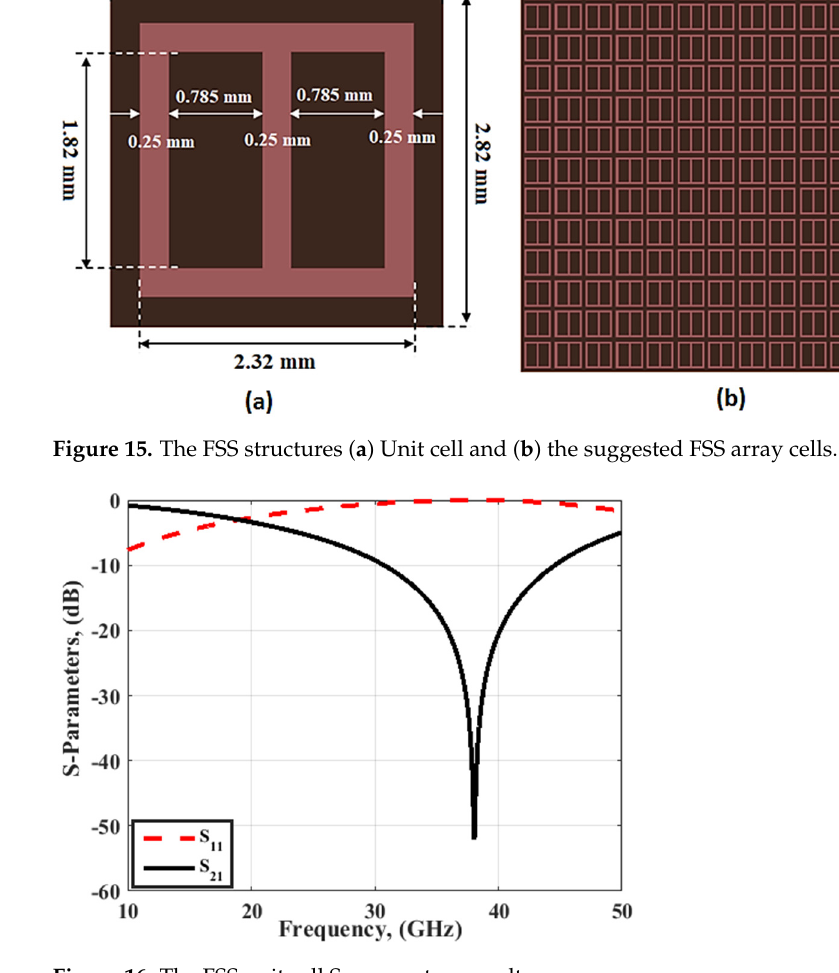
Figure 16. The FSS unit cell S-parameters results.